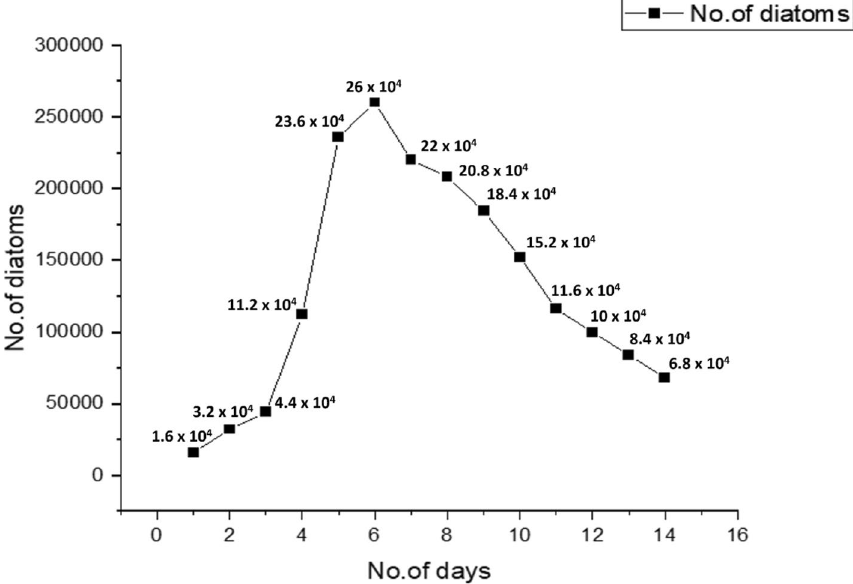
Figure 7. Logarithmic growth curve analysis of Diatom Nitzschia palea for 14 days, cultured in 100 mL of PM culture broth.